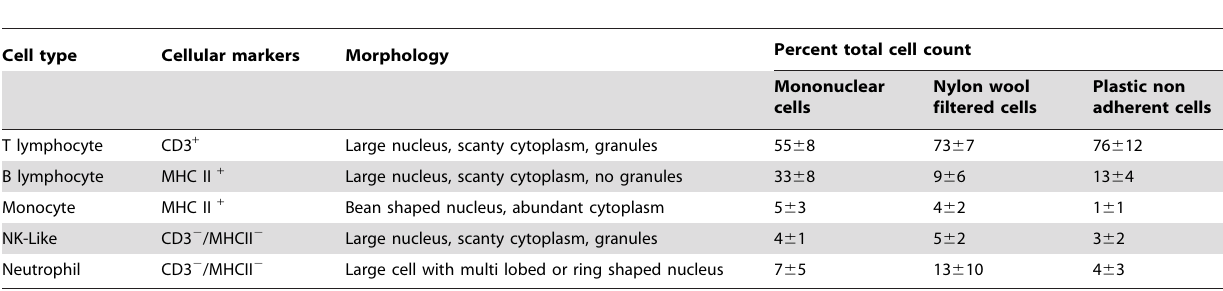
Table 1. Percentages of leukocytes in Tasmanian devil peripheral blood mononuclear cell, nylon wool filtered and plastic non adherent cell